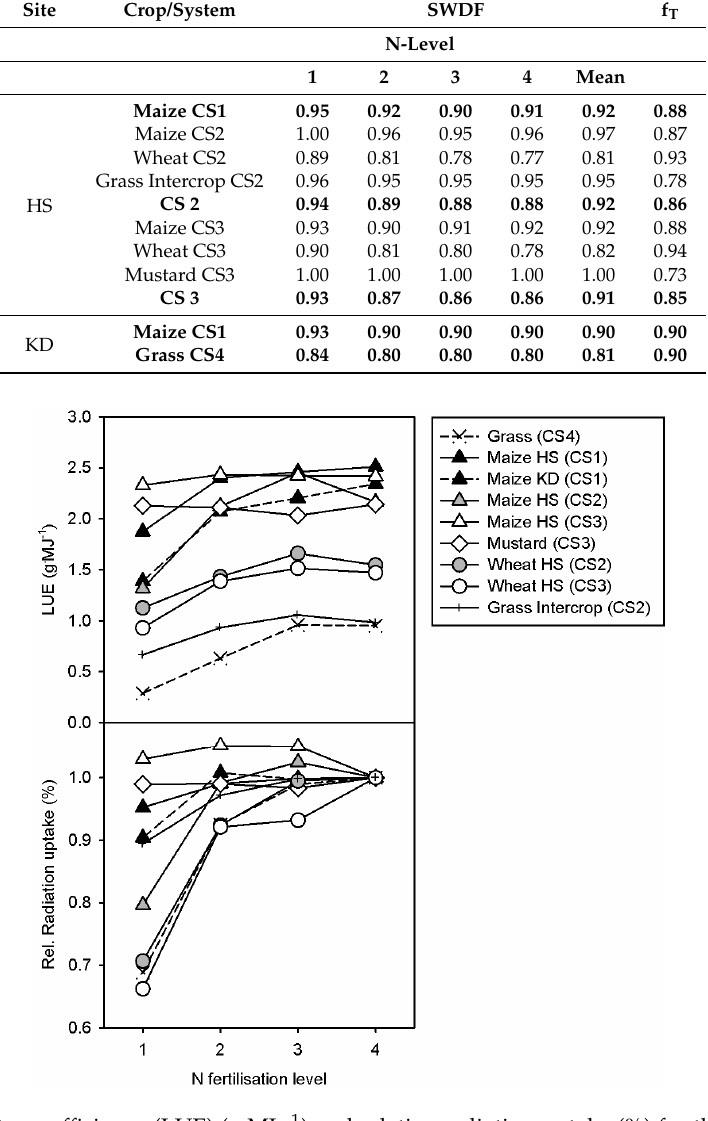
Figure 4. Light use efficiency (LUE) (g MJ − 1 ) and relative radiation uptake (%) for the crops of the different cropping systems as a function of the N fertilization level of the cropping systems (CS1– CS4) cultivated at Hohenschulen (HS) and Karkendamm (KD).